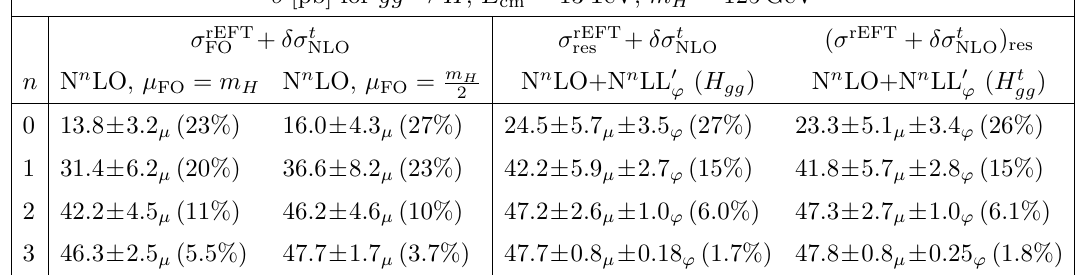
Table 1 . Total gg ! H cross section at E cm = 13 TeV and m H = 125 GeV. All results include